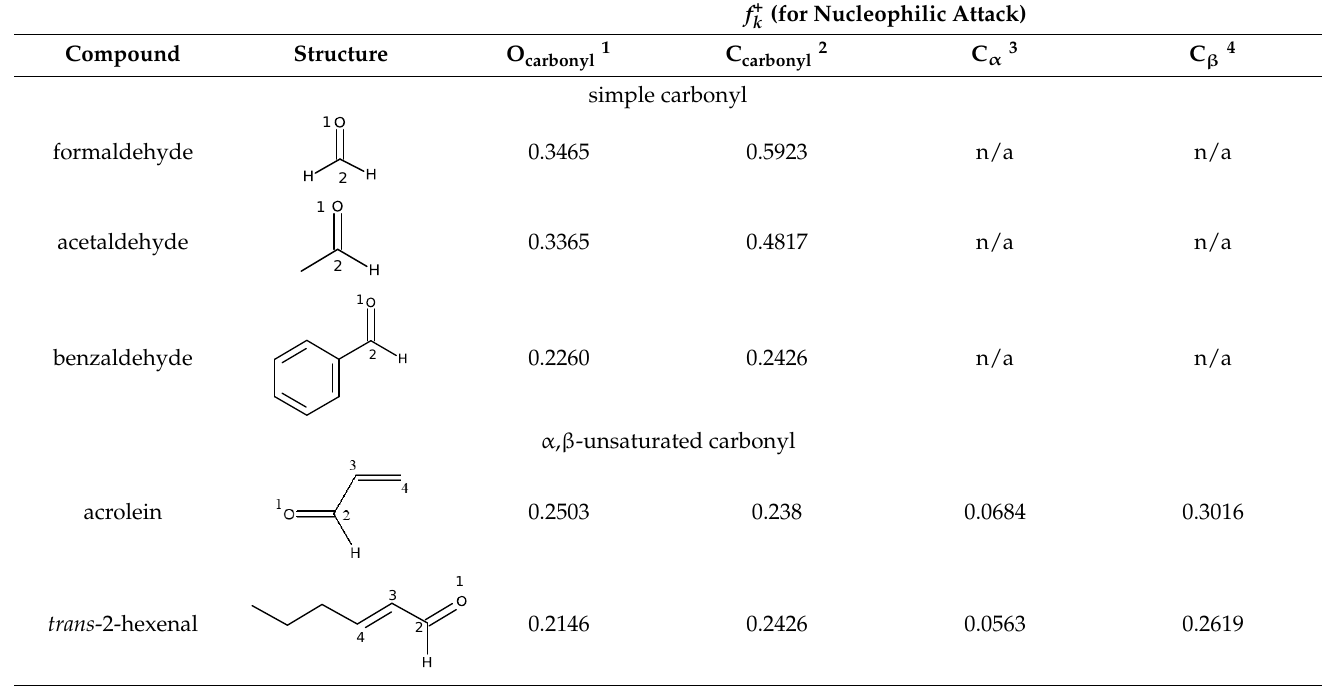
Table 3. Condensed Fukui function, 𝑓 𝑘+ , of carbonyl compounds calculated using the UCA-FUKUI software. 𝒇 𝒌+ (for Nucleophilic Attack)